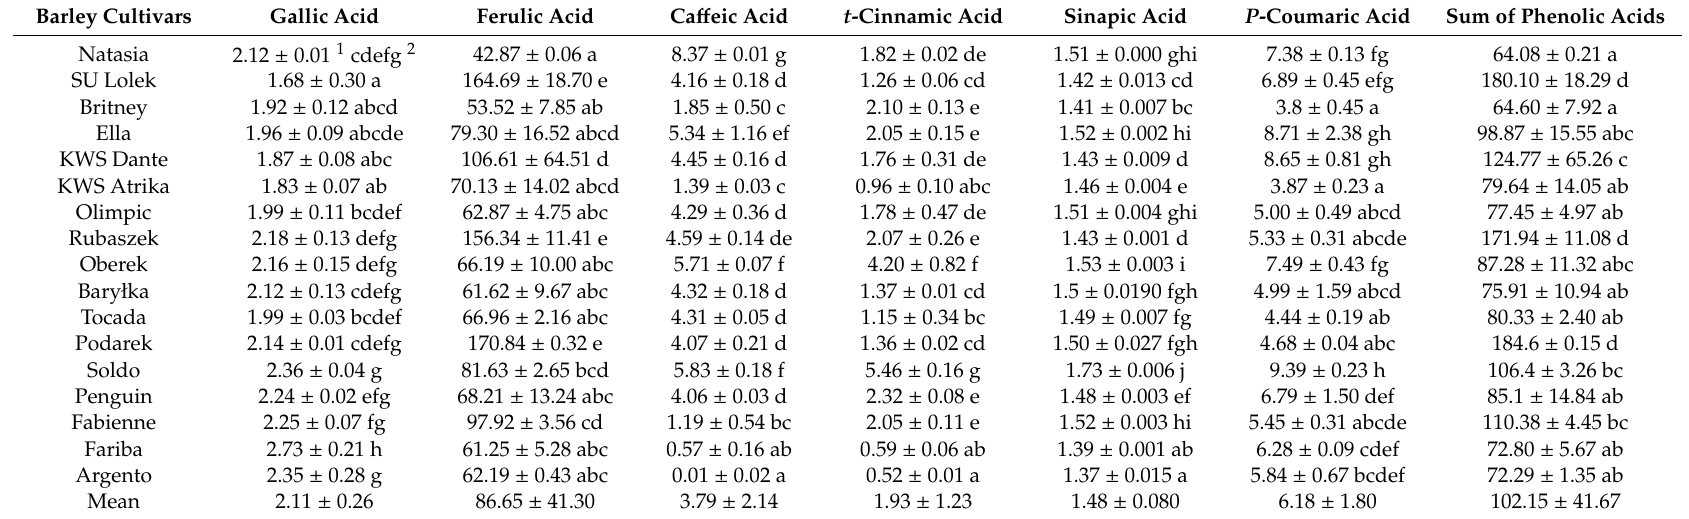
Table 2. Phenolic acids concentrations (mg 100 g − 1 ) in the grain of 17 barley cultivars grown organically in the controlled field trial in Poland.